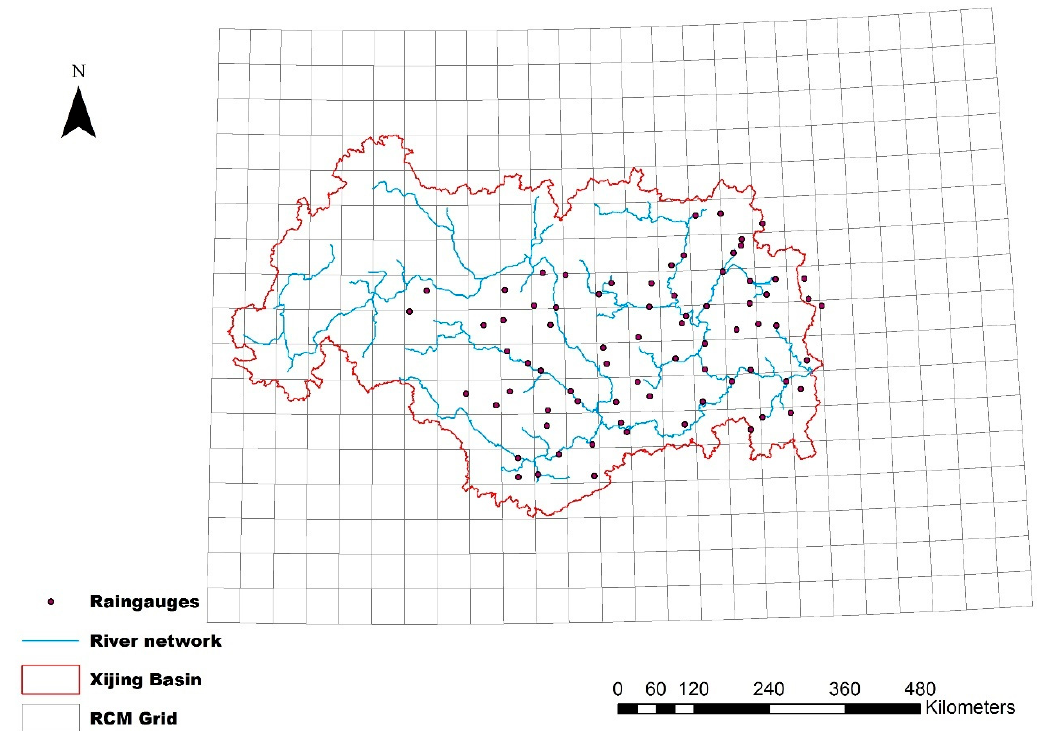
Figure 4. The distribution of Regional Climate Model (RCM) grids on the Xijiang Basin.